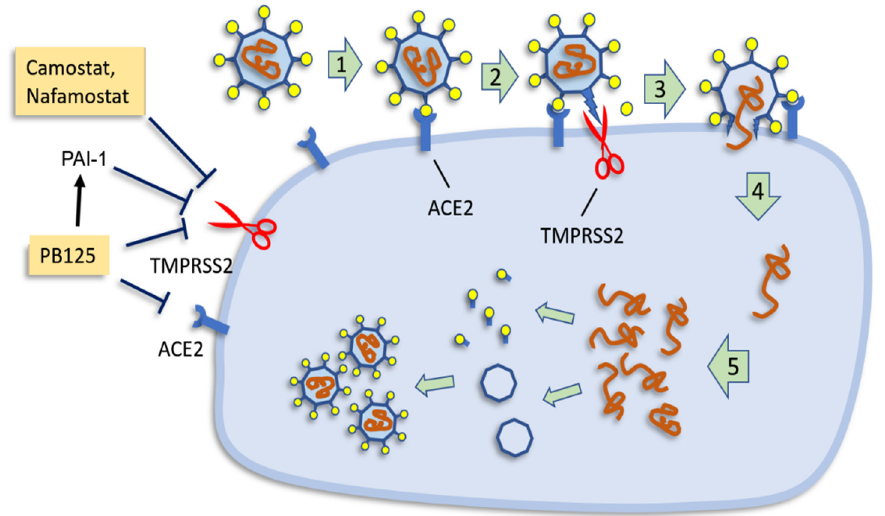
Figure 4. The replication cycle of SARS-CoV-2. Binding of virus to the cell membrane (1) occurs via ACE2 receptors. The spike protein must then be cleaved (indicated as scissors representing serine protease TMPRSS2) to allow entry into the cell (2). The activated spike protein penetrates the cell membrane (3), allowing entry of the viral genome (4), which is replicated, translated, and assembled into mature virus particles (5). On the left, TMPRSS2 inhibition is shown by the antiviral drugs Camostat and Nafamostat, as well as by plasminogen activator inhibitor, PAI-1, encoded by the SERPINE1 gene. PB125 upregulates PAI-2 and downregulates both TMPRSS2 and ACE2 in HepG2 cells.